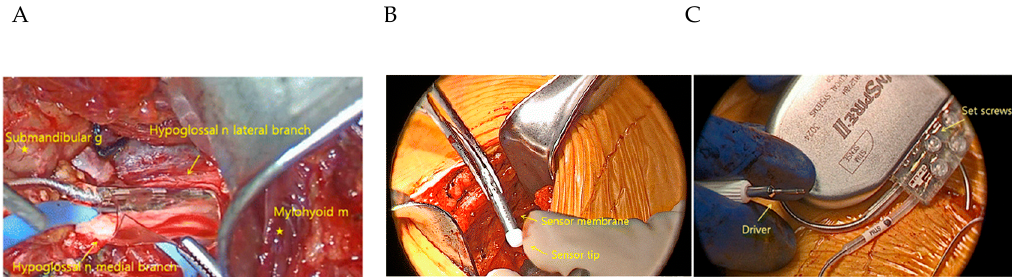
Figure 7. Hypoglossal nerve stimulation. ( A ) Cuff electrodes encircling the medial branch of the hypoglossal nerve (nerve = n, muscle = m, gland = g). ( B ) A pleural pressure-sensing lead is placed with the ventilatory sensor facing the pleura. ( C ) Implantable pulse generator (IPG) with profile connector ports that house the stimulation and pleural pressure-sensing lead connectors. From Hong et al. with permission [24].